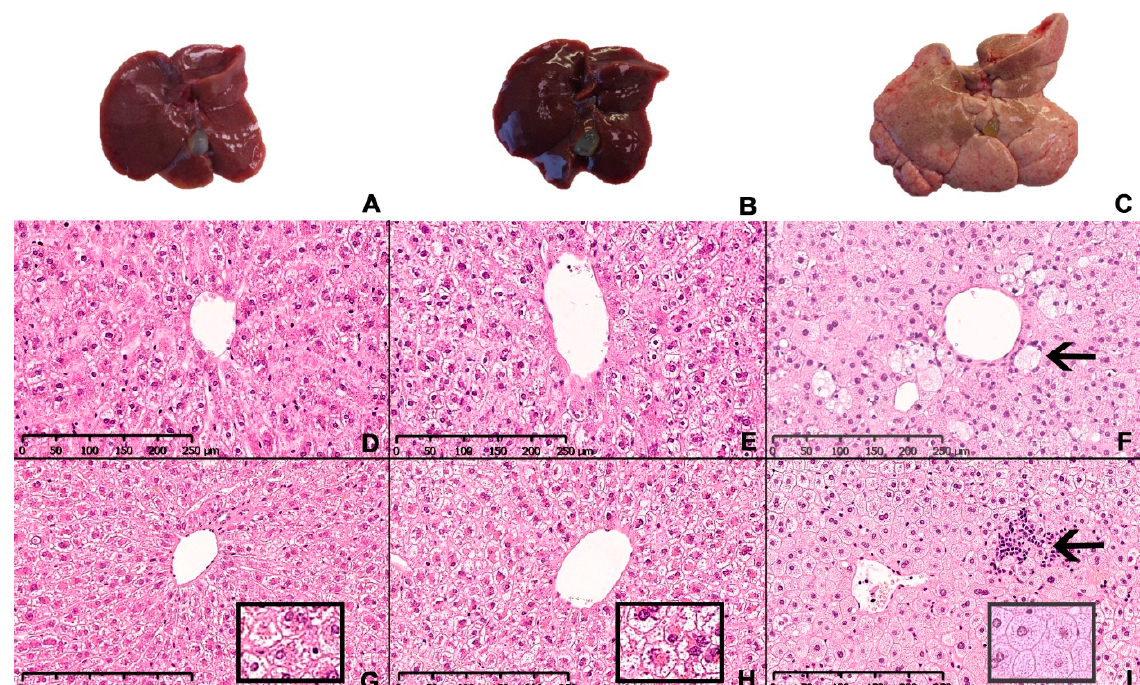
Figure 5. Hepatic macroscopic appearance and histology in Syrian hamsters after exposure to either the NASH diet or the two control diets for eight or 12 months. Macroscopic appearance of excised livers from chow-, CTRL- and NASH-fed hamsters after 12 months ( A – C , respectively). Representative histological sections of liver stained with H&E from each diet group (chow, CTRL, NASH from left to right) at eight ( D – F ) and 12 months ( G – I ). Inserts in ( G – I ): magnified examples (20×) of hepatocyte morphology in chow, CTRL and NASH, respectively, showing pinpoint steatosis in NASH-fed ham-